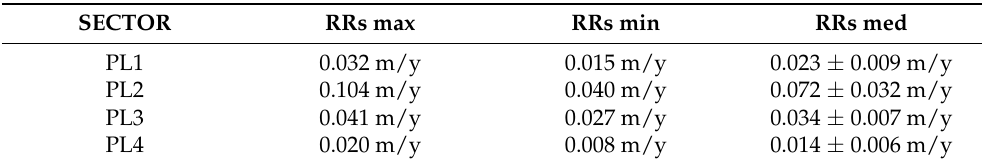
Table 4. Maximum (RRs max), minimum (RRs min) and average (RRs med) retreat rates for the four sectors of the Punta Licosa Promontory (PL1, PL2, PL3, PL4).